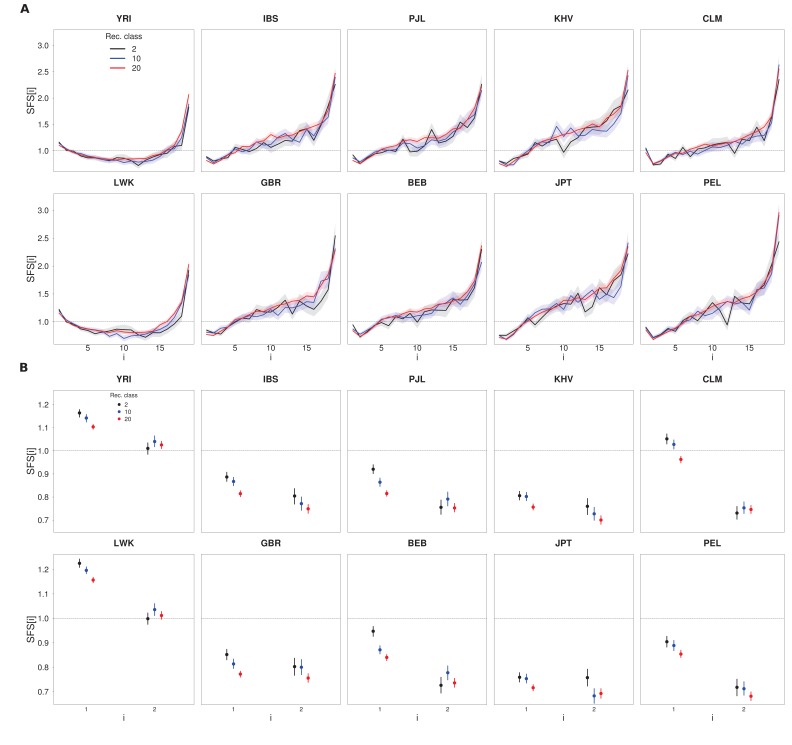
(A) Normalized unfolded SFS of ten 1000G populations for sites belonging to three recombination classes in NTR regions more than 50 kb away from transcribed regions (NTR-50kb sites).(B) Zoom on singletons and doubletons categories. The singletons show a significantly increased frequency in the low-recombination class, in keeping with the action of BGS in non-coding regions. For each panel, pairwise comparisons of the three SFS are significant with p-values<10–3 (see Materials and methods). Shaded areas (panel A) and segments (panel B) correspond to 95% CI obtained by a block-bootstrap approach (see Materials and methods).